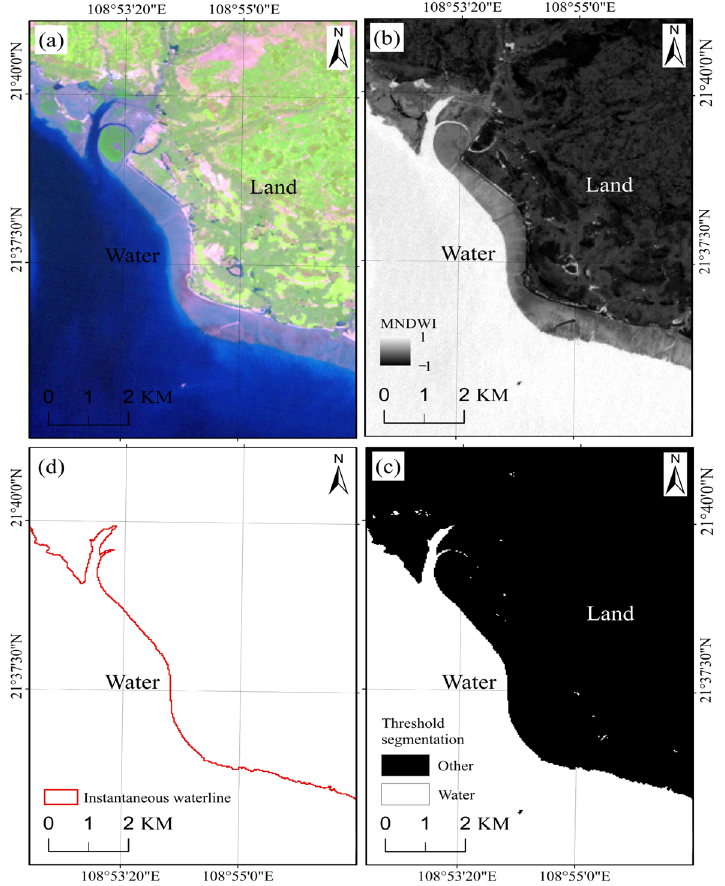
Figure 3. Instantaneous water-edge line extraction process. ( a ) Water edge image to be extracted. ( b ) MNDWI Index. ( c ) Threshold segmentation binarization. ( d ) Instantaneous water edge extraction.